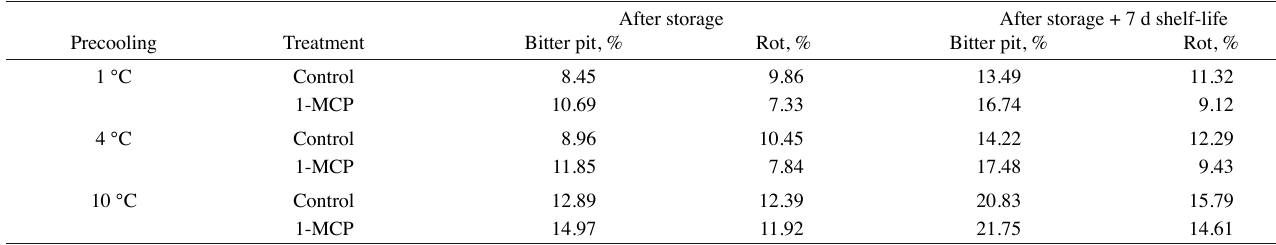
Tab. 2: Bitter pit and rot occurrence after 6 months storage and after shelf-life